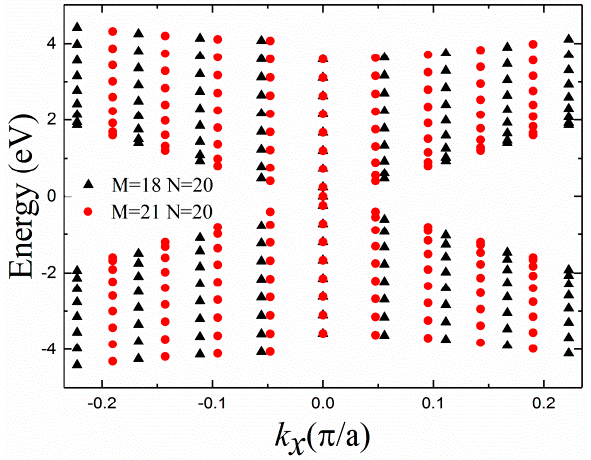
Figure 3. Energy spectra of 3 M 0 sized RGQDs as a function of k x .